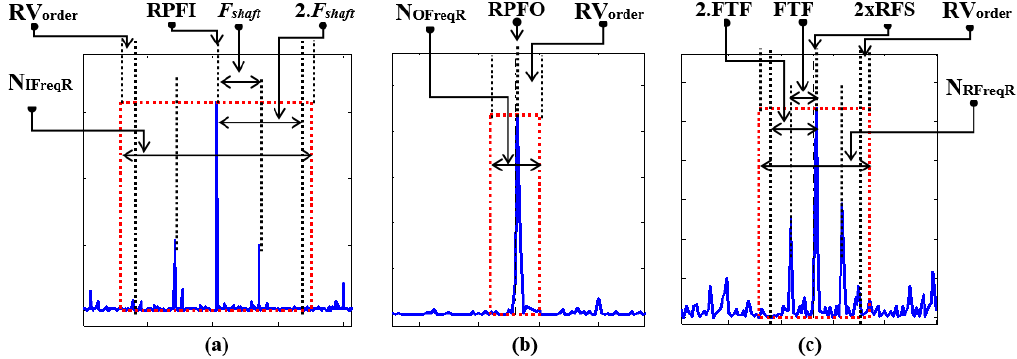
Figure 6. Calculation of N OFreqR , i , N IFreqR , i , and N RFreqR , i . ( a ) Defect frequencies of BCI; ( b ) defect frequencies of BCO; ( c ) defect frequencies of BCR.